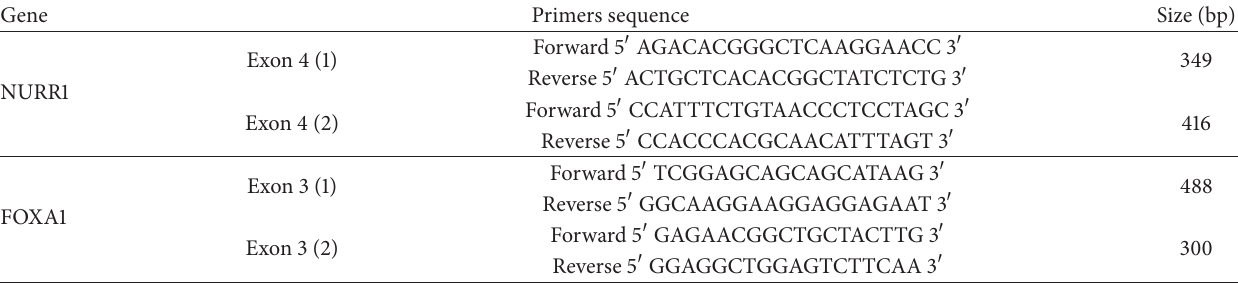
Table 2: Genes with corresponding primers which are used for SSCP